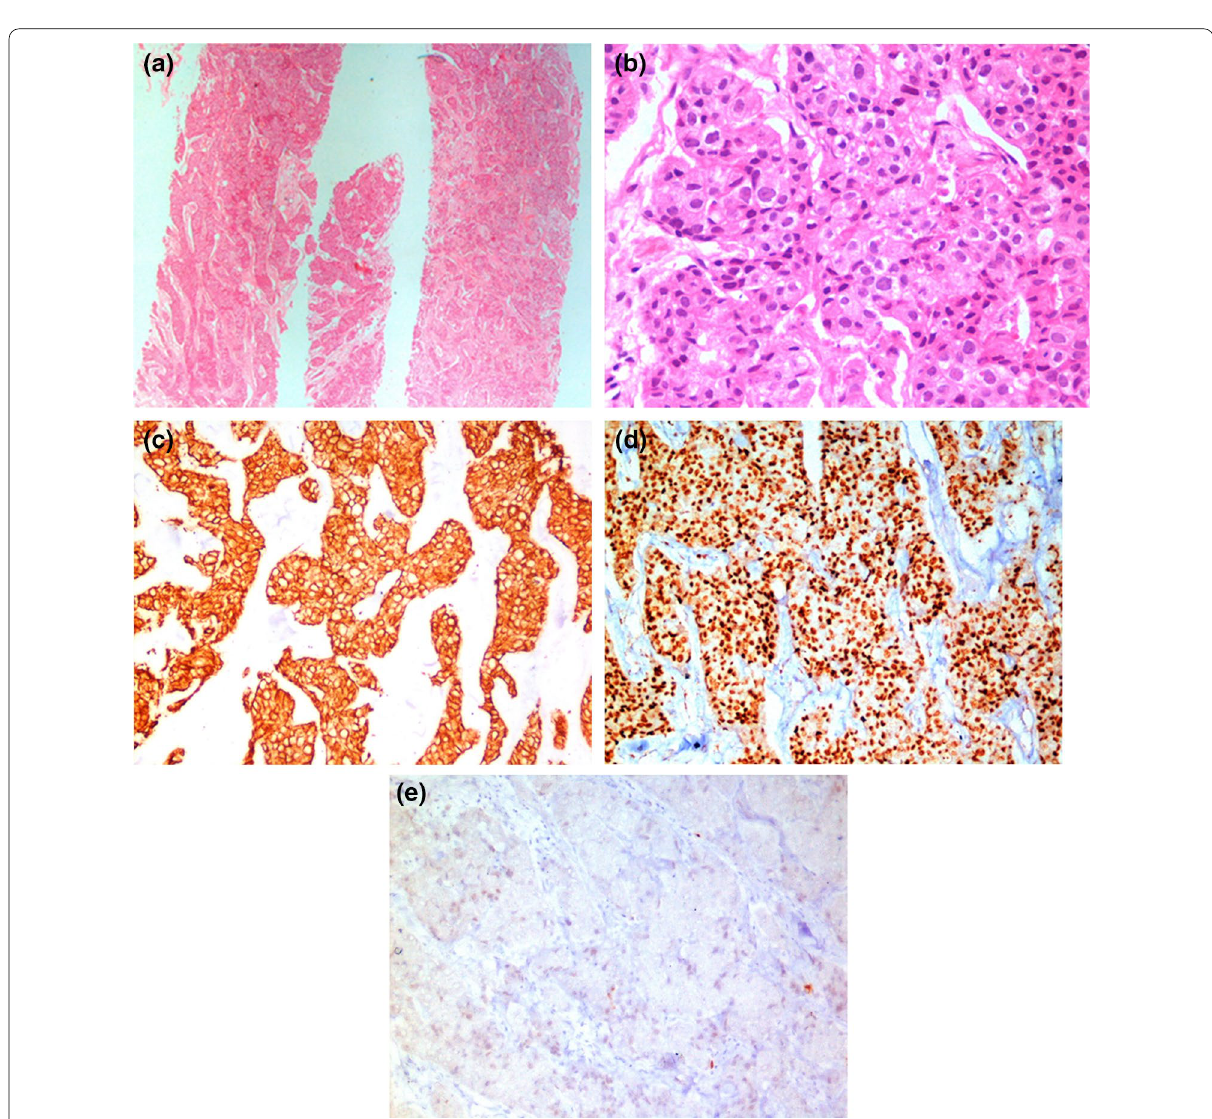
Fig. 3 a Low power magnification view of trucut axillary lymph node biopsy, showing nests of atypical epithelial cells with intervening fibrous stroma. No lymphoid tissue is seen. b High power magnification view, showing nests of atypical epithelial cells with abundant eosinophilic cytoplasm, pleomorphic, hyperchromatic nuclei and intervening fibrous stroma. c Immunohistochemical marker Cytokeratin-7 (CK-7) and Cytokeratin-20 (CK-20) showing diffuse cytoplasmic positivity in tumor cells. d Immunohistochemical marker GATA-3 showing diffuse nuclear positivity in tumor cells. e Immunohistochemical markers Estrogen receptors (ER), Progesterone receptor (PR), GCDFP-15 are negative in tumor